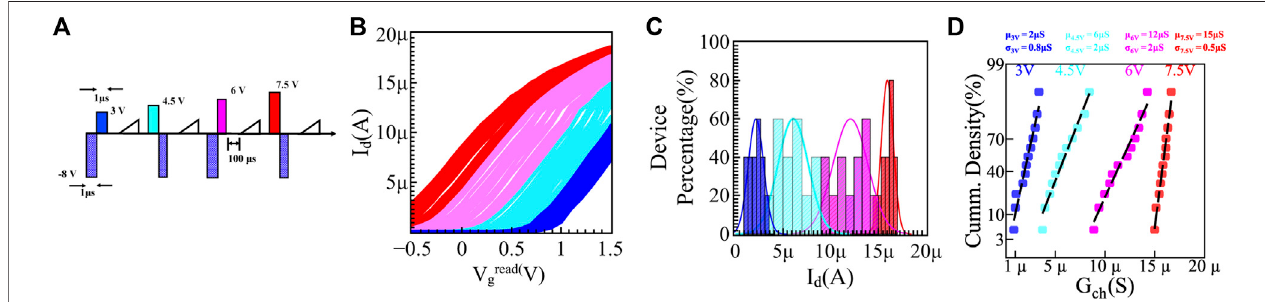
FIGURE5|(A) Pulseschemeusedtoobtain2bits/cell operationamongtwelve Fe- fi nFETdevices. (B) READ operationshows2bits/cell operationin12Fe- fi nFET devices with a gate length 70 nm and fi n width 20 and 10 nm ferroelectric layer. (C) Probability distribution shows four distinct current levels among the devices under consideration. (D) Cycle-to-cycle variation also indicates the presence of four equi-distance current levels in a single